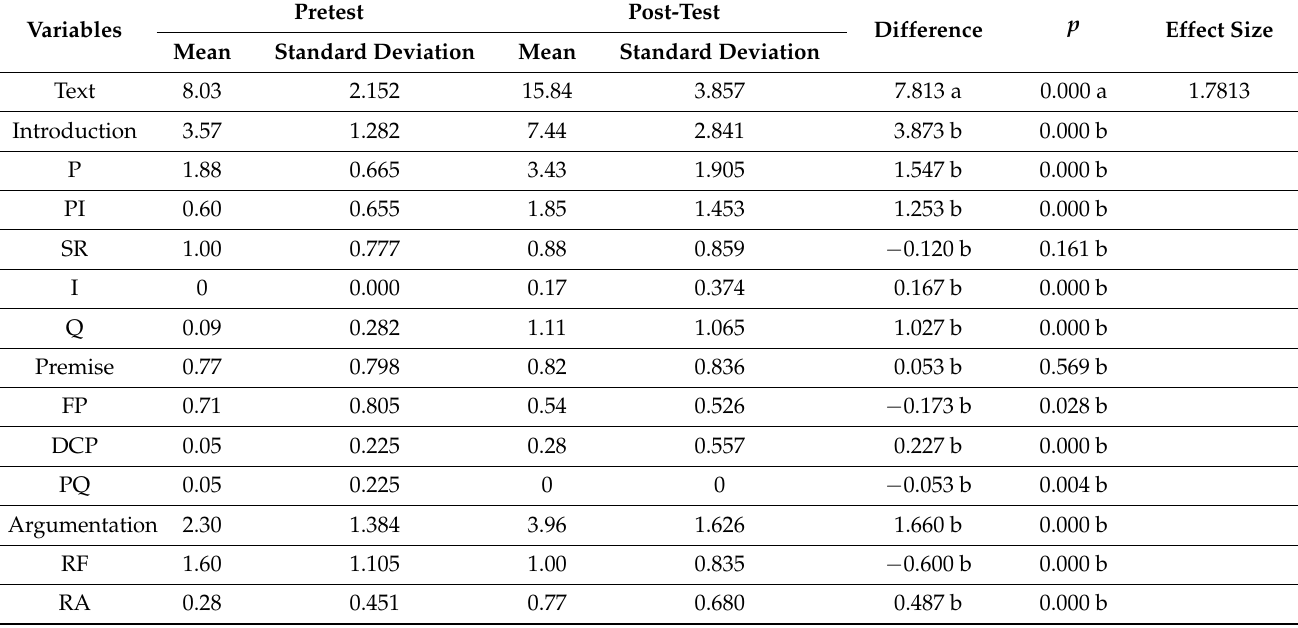
Table 9. Difference in mean frequencies of rhetorical moves and steps and the contrast for the experimental group.